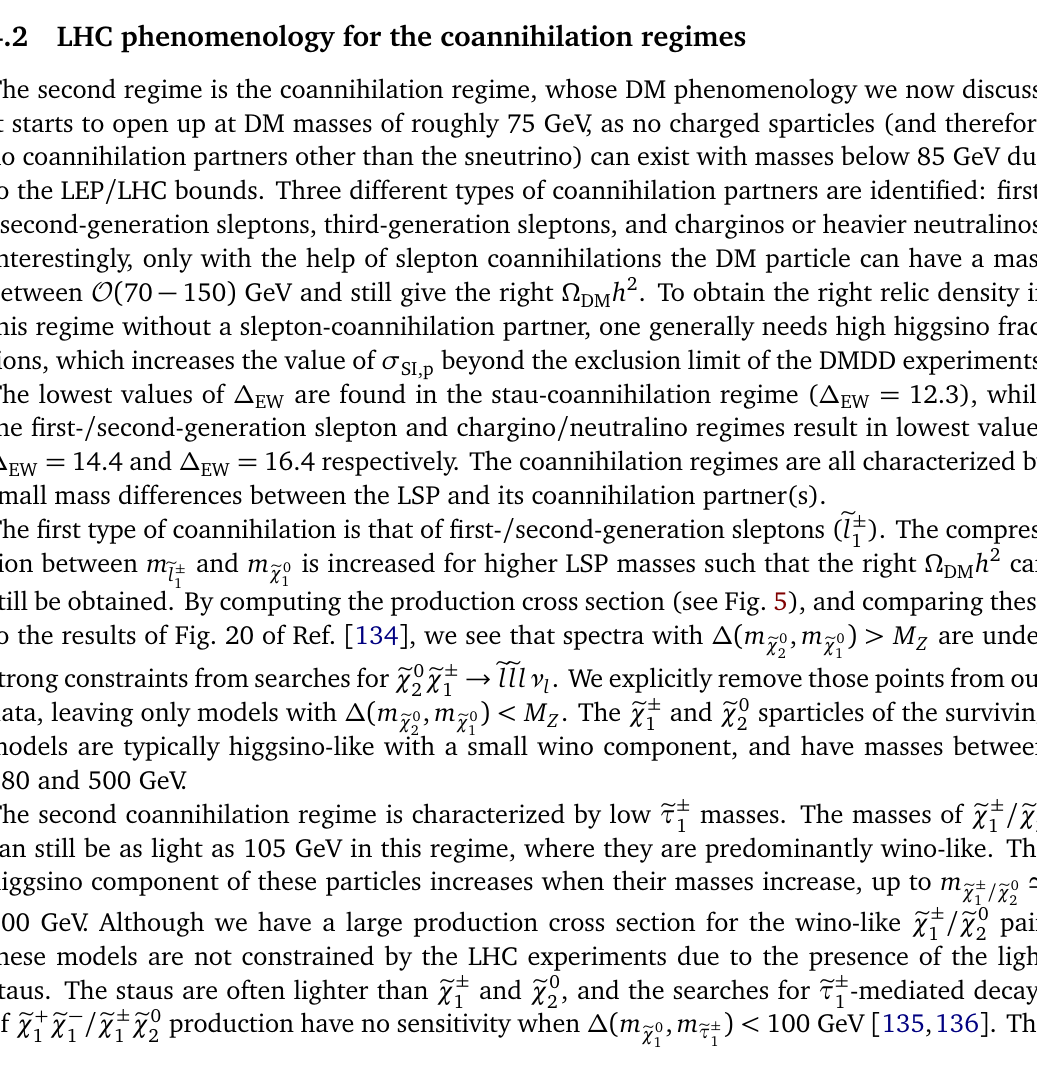
= m , χ ± χ 0 (cid:101) (cid:101) 1 1 = m + M ( m = m + m ) . χ ± χ ± χ 0 χ 0 Z h (cid:101) (cid:101) (cid:101) (cid:101) 1 1 1 1 = m ± χ 0 (cid:101) l (cid:101) 1 1